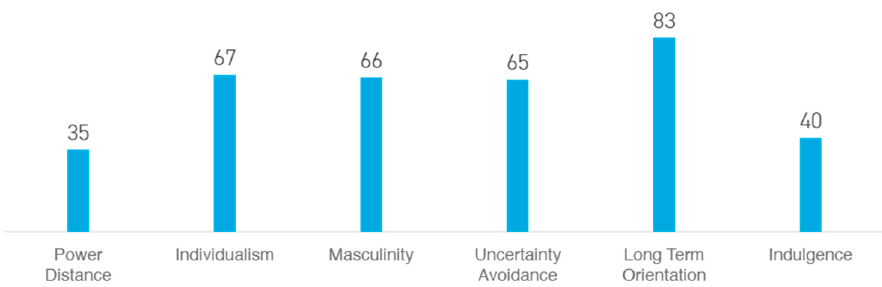
Figure 1. Hofstede dimensions for Germany. Source: (Hofstede Insights 2020).